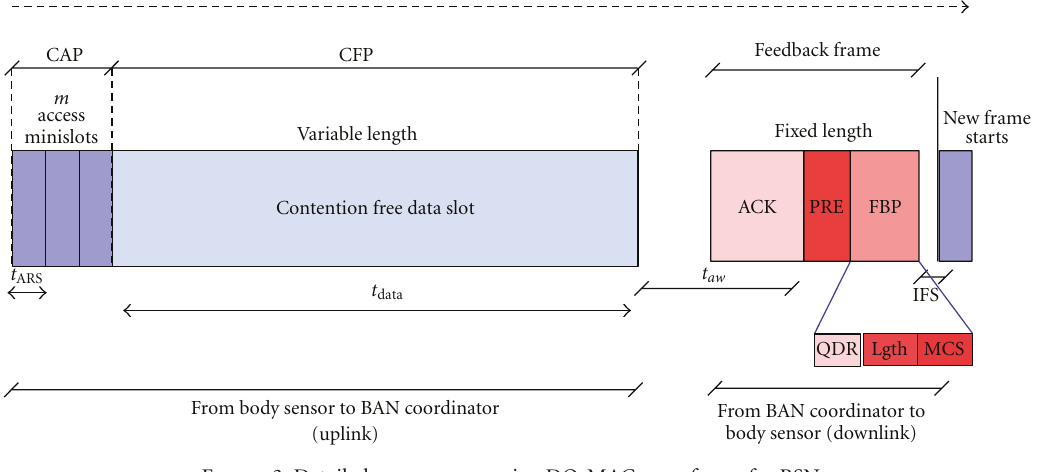
Figure 3: Detailed new energy-saving DQ-MAC superframe for BSNs.